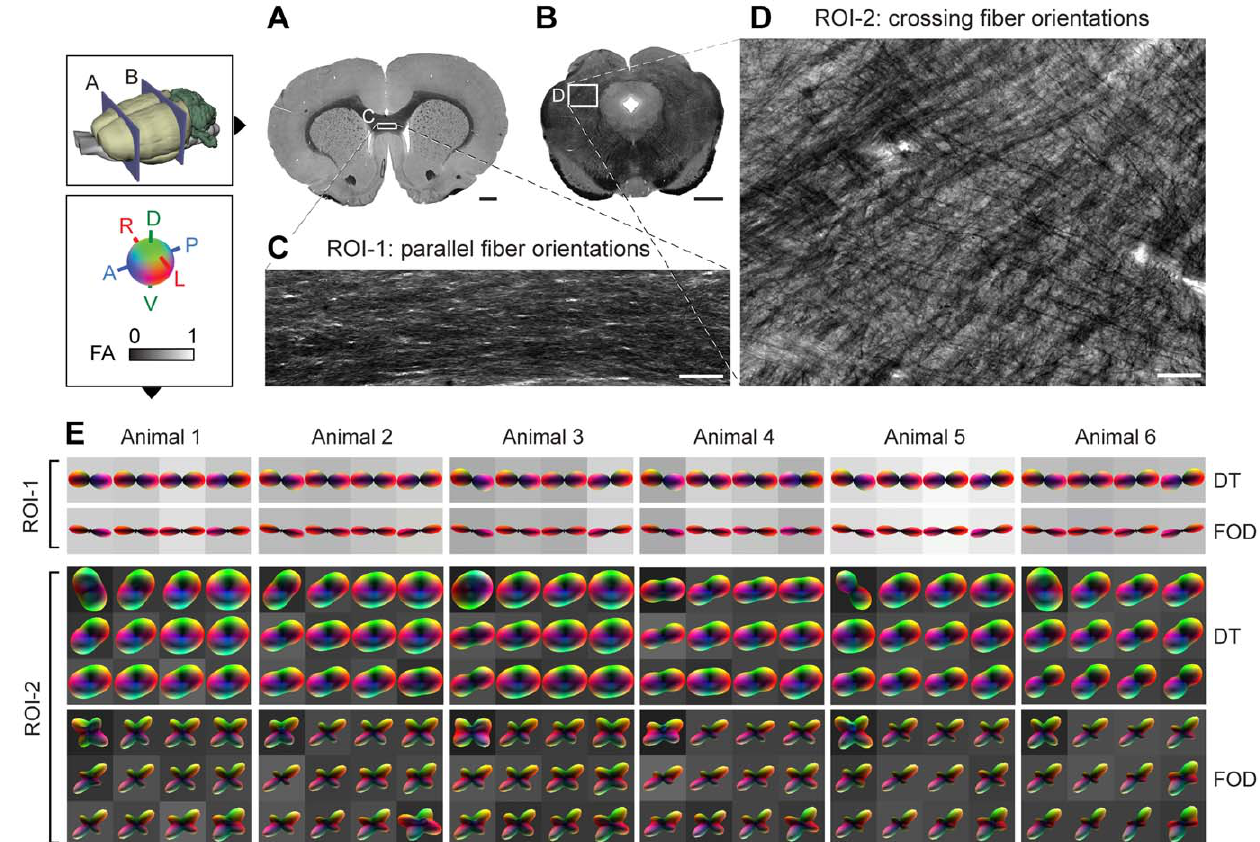
Figure 2. Three-dimensional DT and FOD reconstructions in brain regions with parallel and crossing fiber orientations. ( A–D ) Detailed visualization of the parallel ( A , C ) and crossing ( B , D ) myeloarchitecture in ROI-1 and -2. ( E ) Comparison of 3D DT and FOD reconstructions from ROI-1 and -2 across all six animal specimens. Reconstructions are overlaid on a gray scale map of the fractional anisotropy (FA) index [55] derived from the DT eigenvalues and quantifying the overall degree of diffusion anisotropy on a 0–1 scale (1 being highly anisotropic and 0 being isotropic). The high FA values and elongated DT and FOD profiles in ROI-1 are characteristic of coherent (parallel) fiber orientations, while the low FA values and disk-like DT profiles in ROI-2 are characteristic of crossing fibers, which is further evidenced by the FOD reconstructions and myeloarchitecture. All DT and FOD reconstructions are shown min-max normalized for reasons discussed in the main text. Scale bars, 1 mm ( A,C ) and 100 m m ( C,D ).